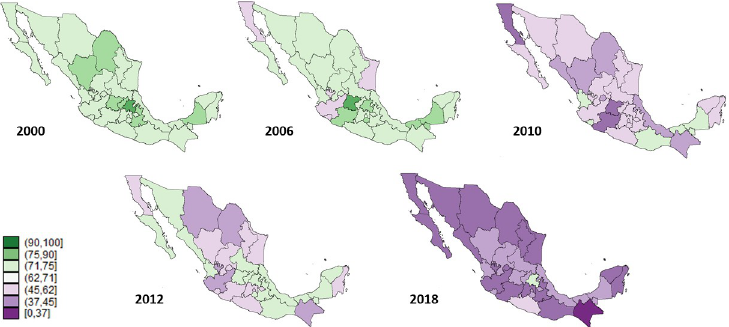
Fig 3. Estimated coverage of the complete basic scheme in the 12–23 months population, Mexico 2000–2018.